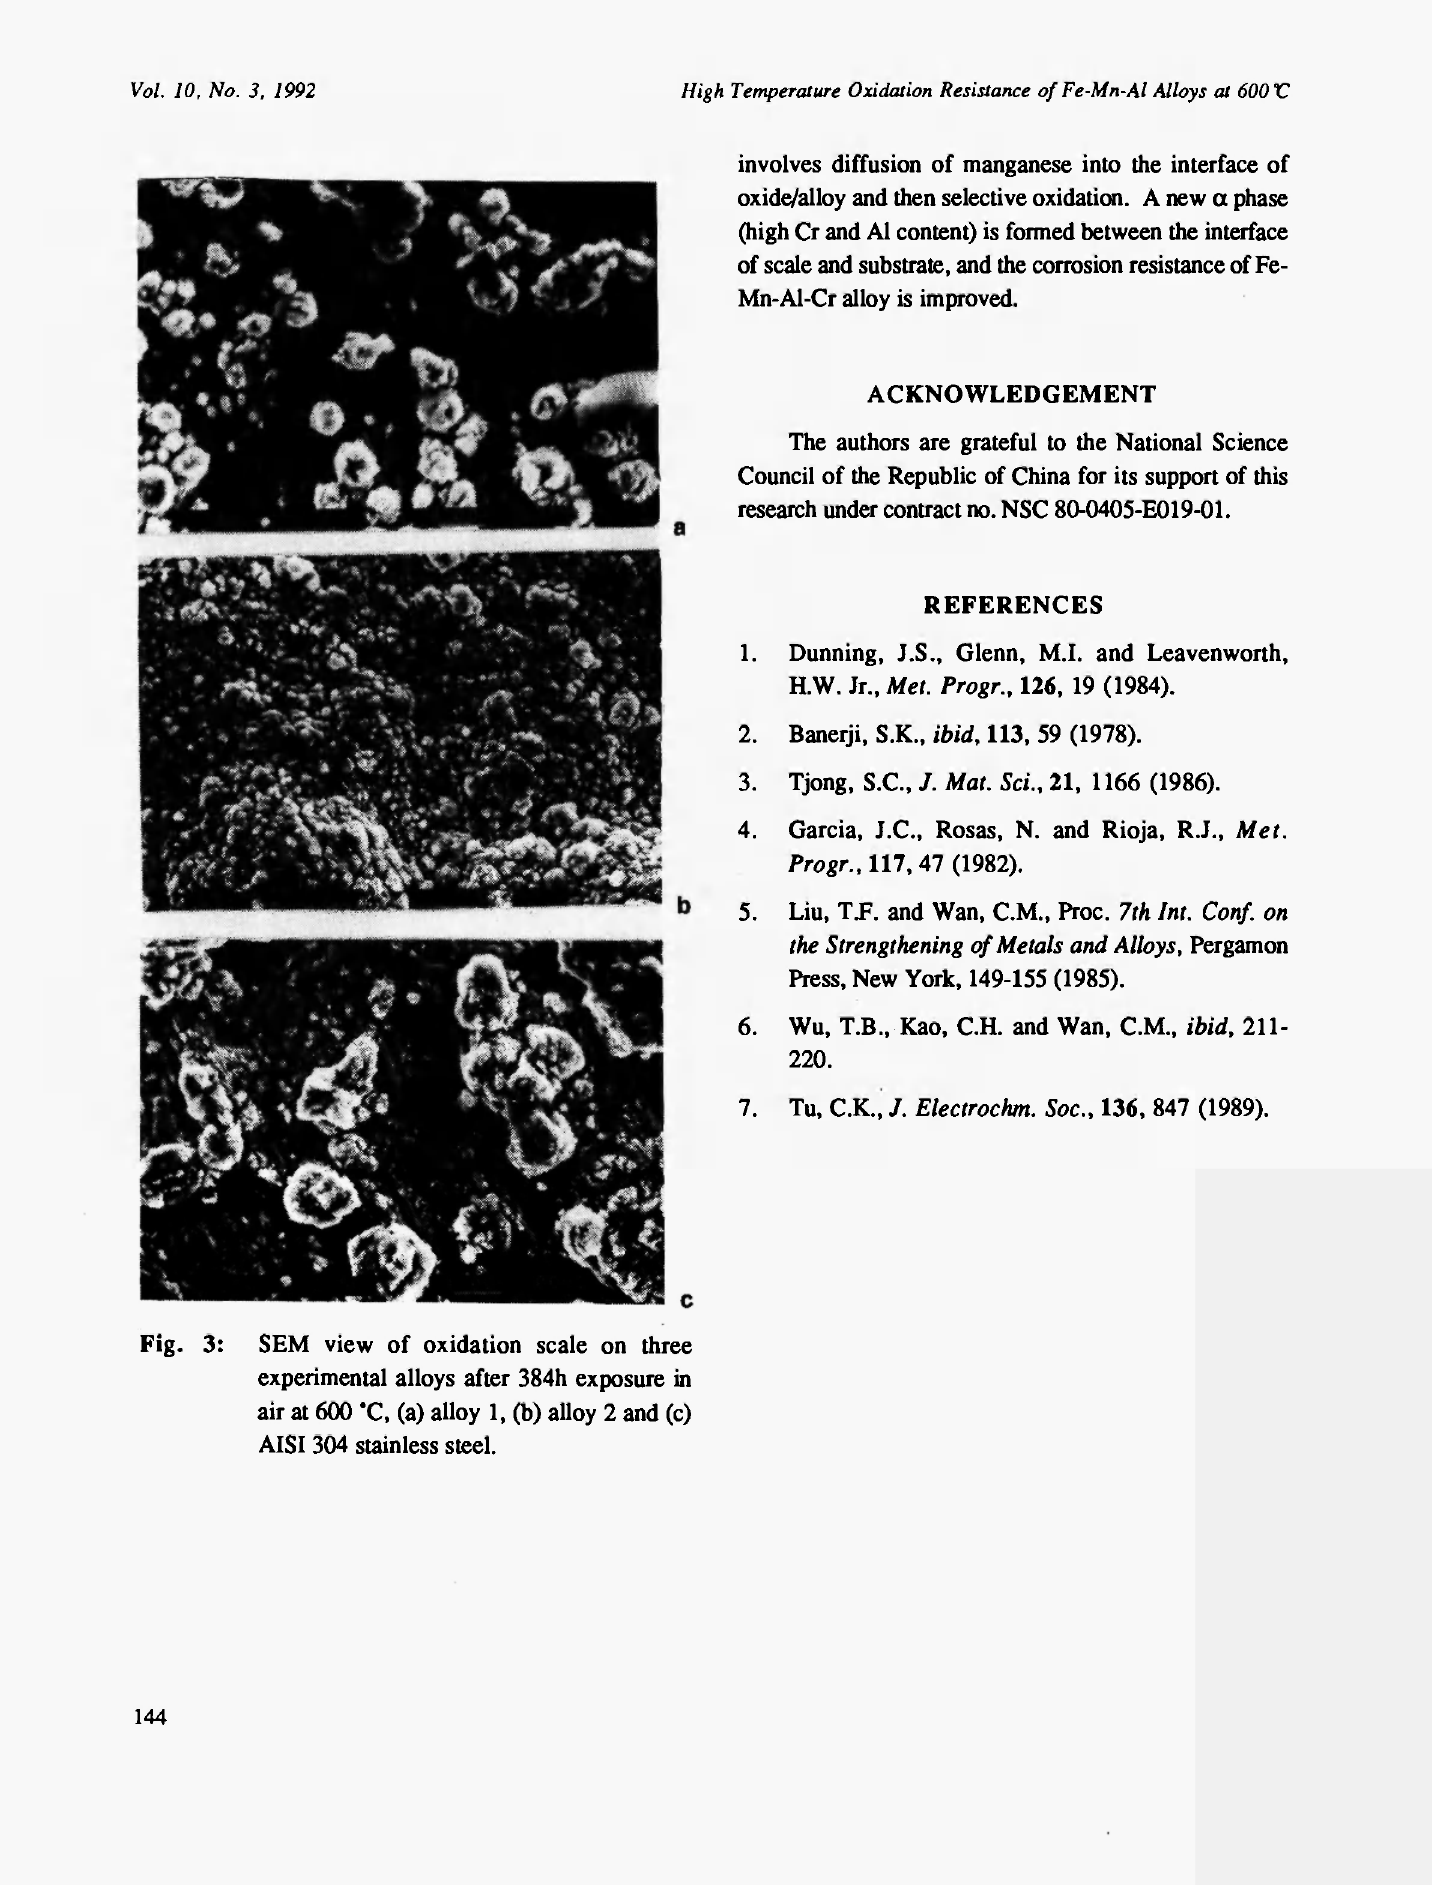
Fig. 3: SEM view of oxidation scale on three experimental alloys after 384h exposure in air at 600 'C, (a) alloy 1, (b) alloy 2 and (c) AISI 304 stainless